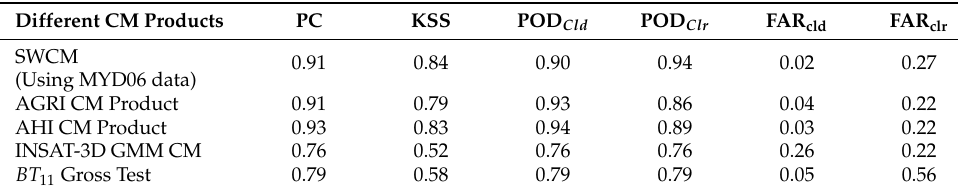
Table 7. Other test and cloud mask results